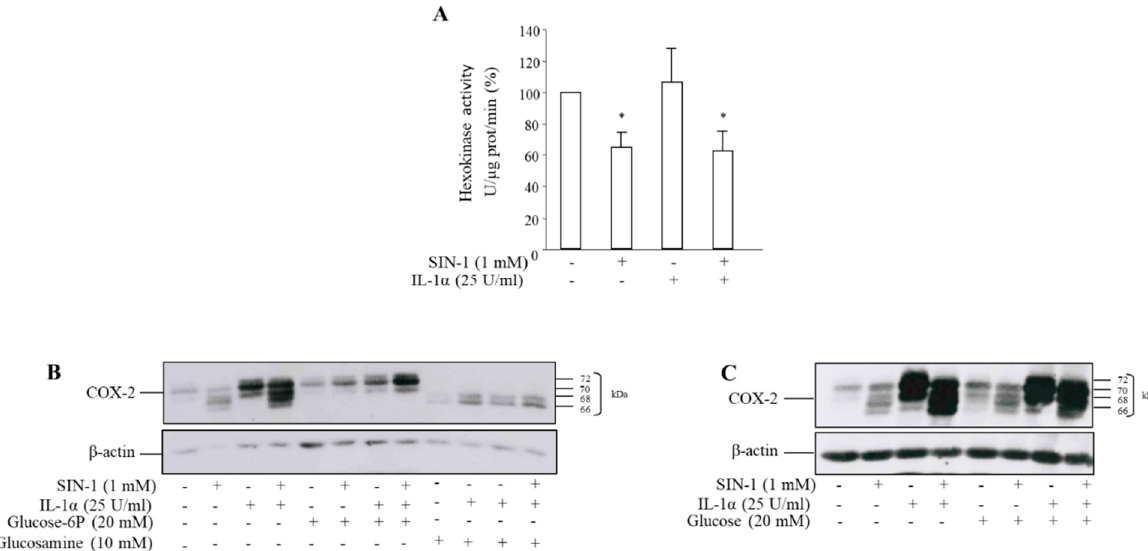
Figure 5. SIN-1 reduces the hexokinase activity. HUVEC were treated with SIN-1 or IL-1 α either alone, or in combination for 18 h. ( A ) Hexokinase activity was measured by fluorimetry through the conversion of NAD + to NADH in a glucose-6-phosphate dehydrogenase-coupled reaction. n = 4; * p < 0.05 vs. cells incubated in the absence of SIN-1. Cells were treated with the stimuli in the presence of ( B ) glucose-6P or of the hexokinase inhibitor glucosamine, or ( C ) glucose. ( D ). COX-2 expression was evaluated by Western blot analysis. β -actin was used as a control of protein loading. Results are representative of 3 independent experiments.